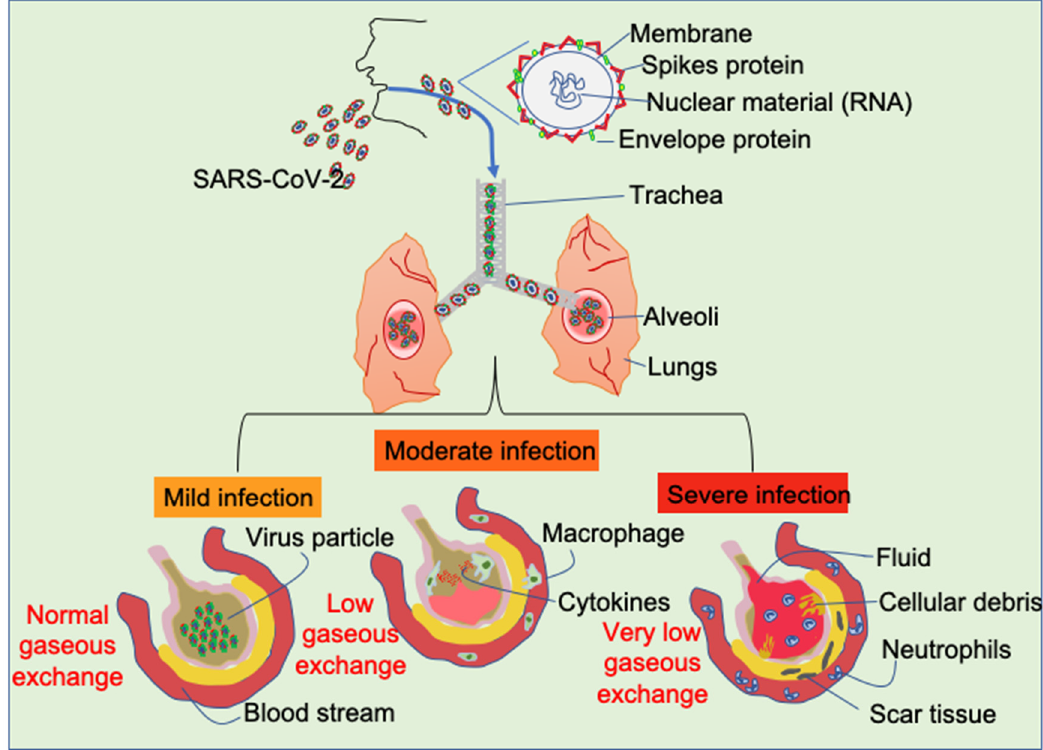
Figure 1. Effect of SARS-CoV-2 infection on the alveolar cells depending the severity of the infection. Figure 1. E ff ect of SARS-CoV-2 infection on the alveolar cells depending the severity of the